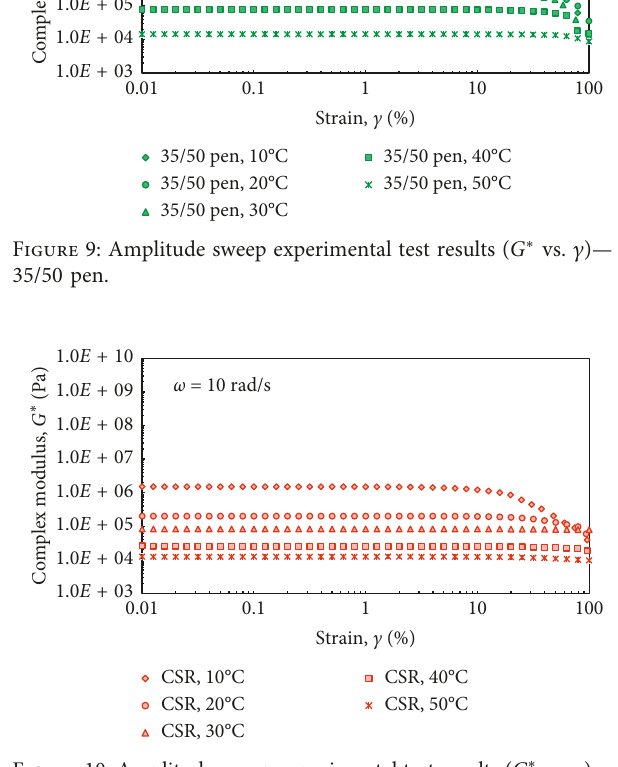
vs. c )— ∗ and ∗ Figure 12: Black diagram ( δ vs. G